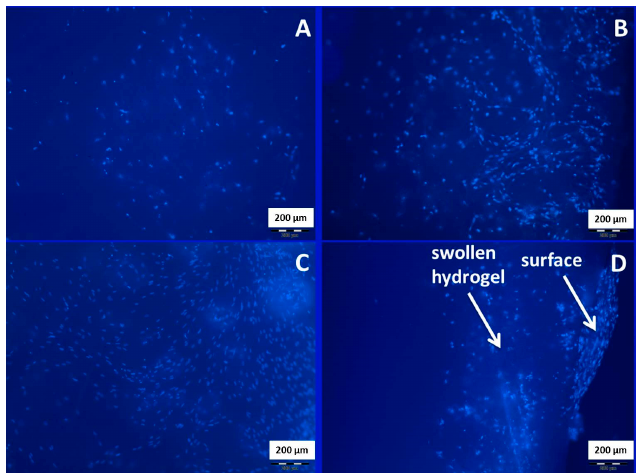
Figure 13. Microphotographs of 4 ′ ,6-diamidino-2-phenylindole (DAPI)-stained MCS cells on the surface: ( A ) PLA; ( B ) PLA-PAAm; ( C ) PLA-Alg; ( D ) the PLA-Alg film cut.